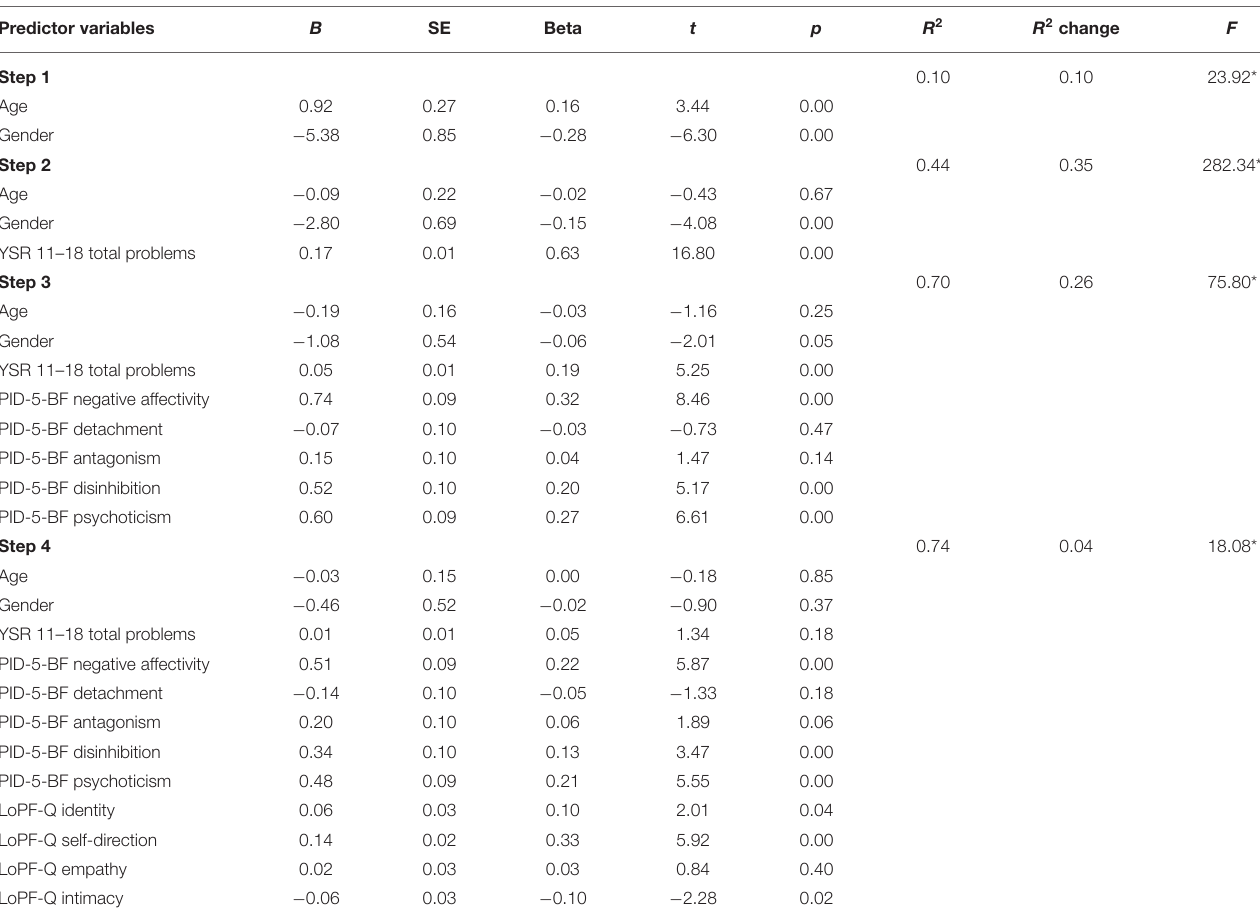
TABLE 3 | Hierarchical linear regression analysis for predicting BPFSC-11